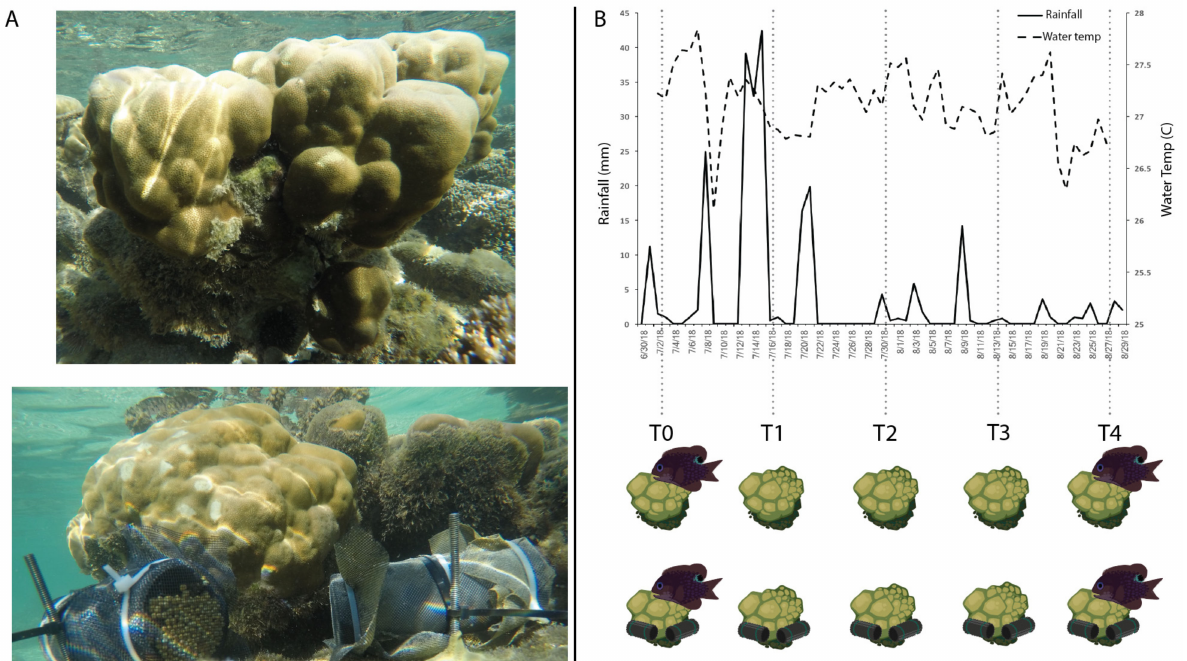
Figure 1. Experimental nutrient enrichment set up. ( A ) In situ Porites lobata colonies inhabited by turf algae farming Stegastes nigricans , on a northern fringing reef in Mo’orea French Polynesia, were left untreated ( n = 7) (top image), or exposed to Osmocote © slow-release nutrient diffusers ( n = 7) (bottom image). ( B ) Sampling of P. lobata , algal matrix, and S. nigricans started on 7/02/18, and continued over an 8-week period, sampling every two weeks. Local rainfall and water temperature was recorded over the experimental period (B top graph). The fish S. nigricans were only sampled on the first and last timepoints (T0 and T4), while the coral P. lobata and turf algae were sampled for every timepoint (T0 to T4) (B bottom